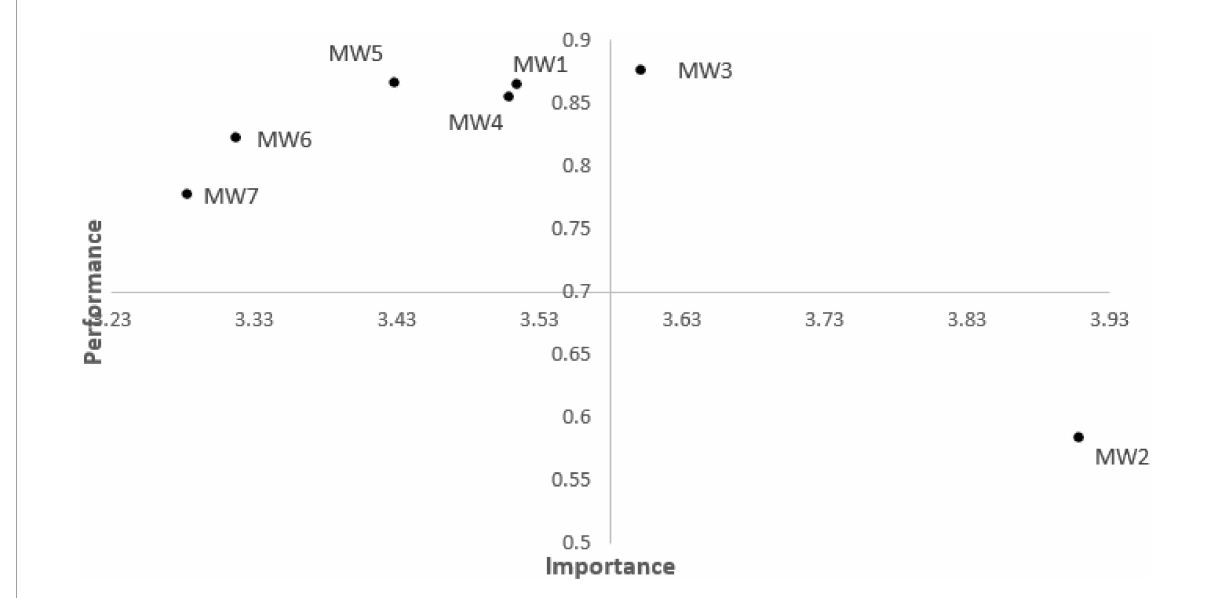
FIGURE4 Importance-performance map for meaning of work indicators. MW, meaning of